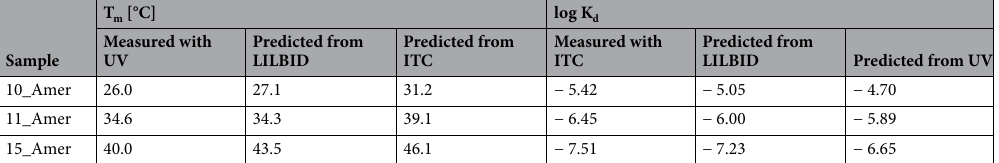
Table 3. Measured and predicted T m s and log K d s. Each value represents the mean of all replicates. Note nine dsDNAs were measured with UV and with LILBID, but only seven of these could be measured with ITC. Thus, models involving ITC measurements include seven dsDNAs, whereas all other models include nine